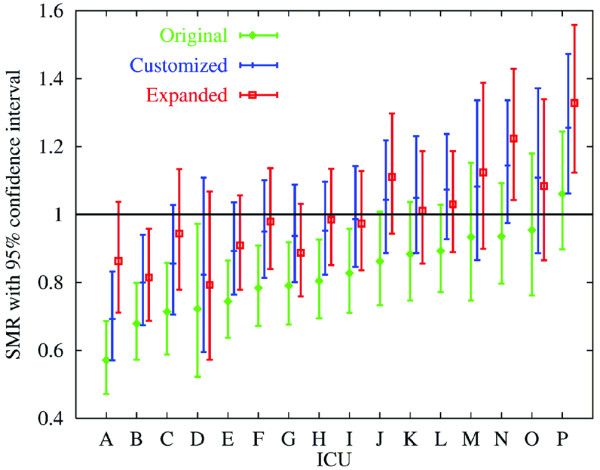
ICU performance as assessed using the three SAPS II models. Shown are standardized mortality ratio (SMR) values for 16 units with more than 300 patients, using either the original, the expanded, or the customized Simplified Acute Physiology Score (SAPS) II. A–P indicate different intensive care units (ICUs).